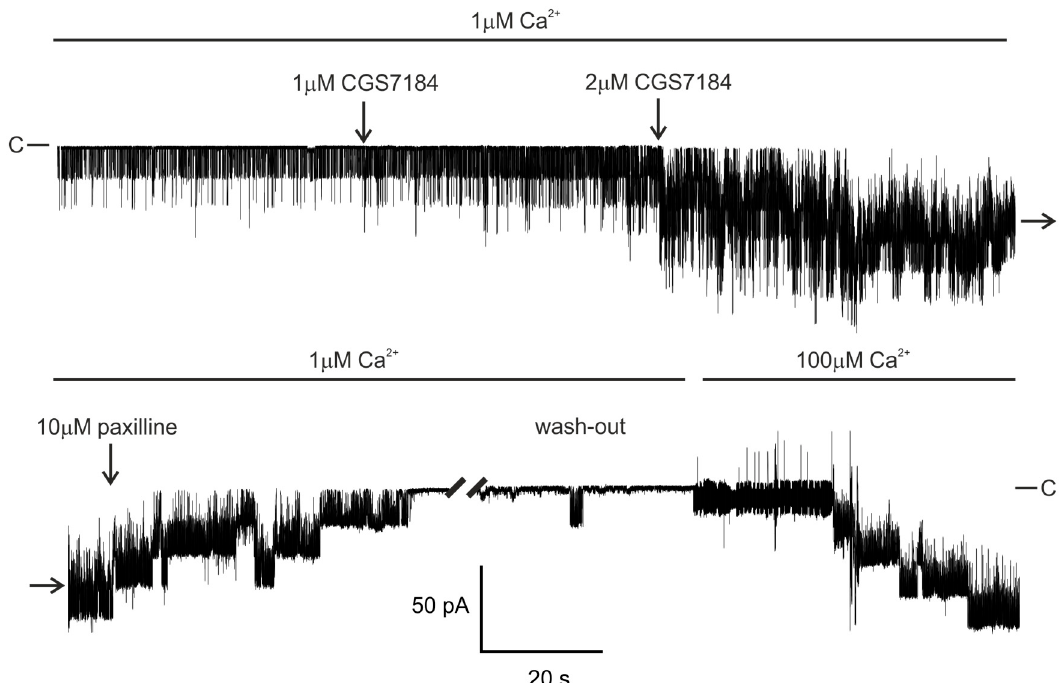
Figure 1. The mitochondrial BK Ca channel is activated by CGS7184. A representative patch-clamp recording of the activity of BK Ca channels detected in mitochondria of the U-87 MG cell line. Continuous recording from one patch at − 60 mV pipette voltage is shown. C—indicates closed channel level. Opening of channels is visible as downward deflections from the closed channel level.